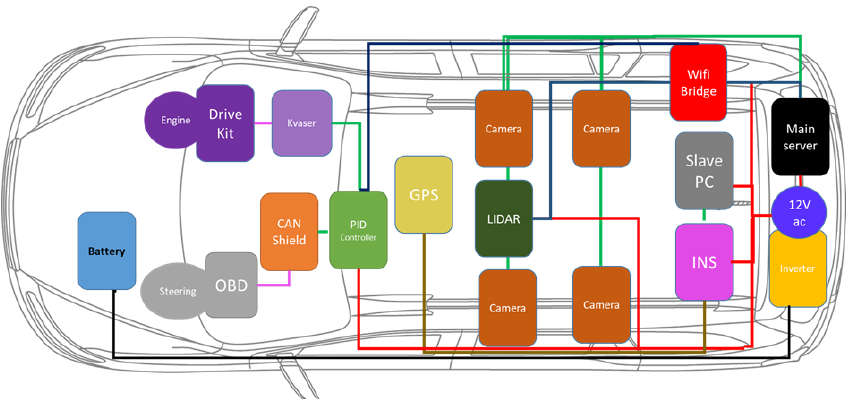
Figure 3. In the wiring diagram, the black color is the connection between the main battery of the car and the inverter. The red color wire shows the power is transmitted to different sensors. The green colors show the connection between sensors which are connected to the computer and are powered through them. The violet color is for the devices which are connected through a network protocol. The brown color is for GPS antenna of the GNSS system. The pink color is for receiving and sending commands to car hardware (Best viewed in